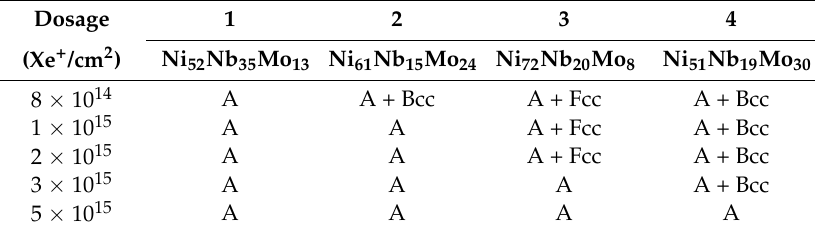
Table 5. Phase transformation for the Ni-Nb-Mo multiply layers upon Xe + beam mixing to different doses [71]. (A: amorphous phase; Bcc: bcc crystalline phase; Fcc: fcc crystalline phase).